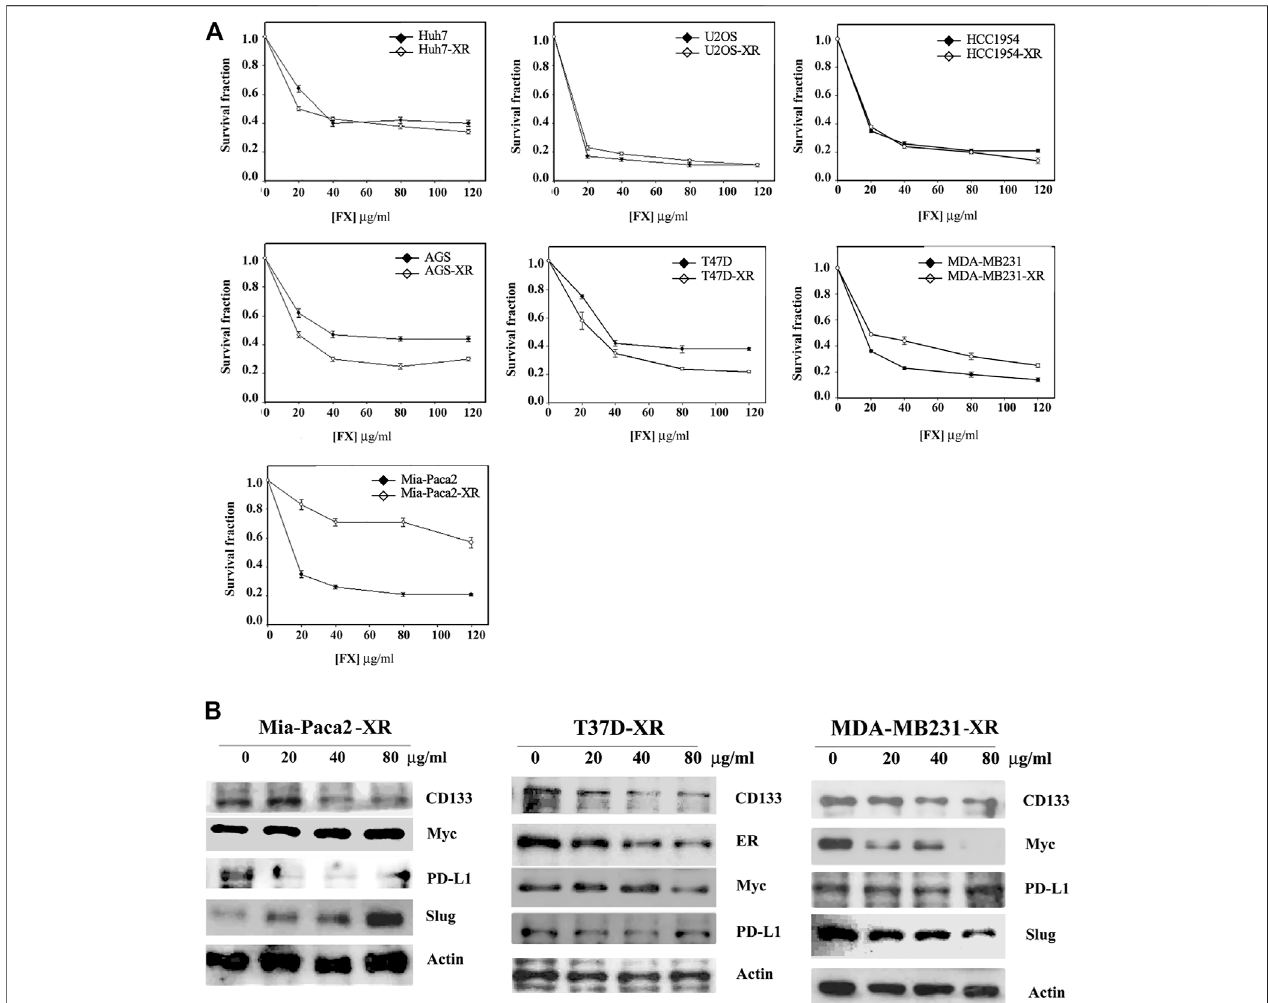
FIGURE 3 | Determination of inducible drug resistance by Formula X treatment. The cells were treated with 40 μ g/ml Formula X (FX) for 24 h and then released for another24 h(-XRcells).Subsequently,theXRcellsweretreatedwithaserialdoseofFormulaXfor4days.ThelevelofsurvivingcellswasdeterminedbyMTTassay.For directcomparison,thecurveofuntreatedcellswasredrawnfrom Figures1A , 2A .Thedataareshownasthemean±SD. (B) TheXRcellsmanipulatedfromMia-Paca2, T47D and MDA-MB231 cells were treated with a serial dose of Formula X. Western blotting analysis showed the change in protein expression in these cells.